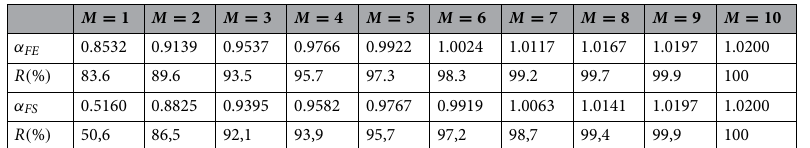
Table 5. Comparison of variance/STD scores for feature selection and Sobol’s total sensitivity metric.